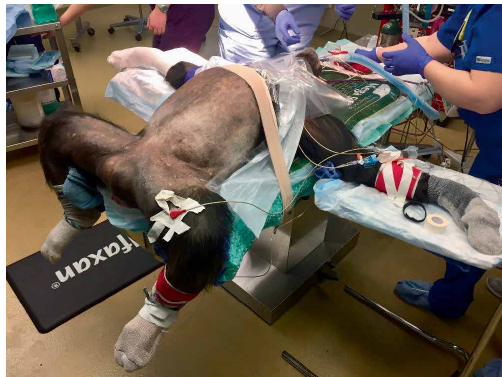
Figure 1: Positioning of the patient in a dorsal low lithotomy position.